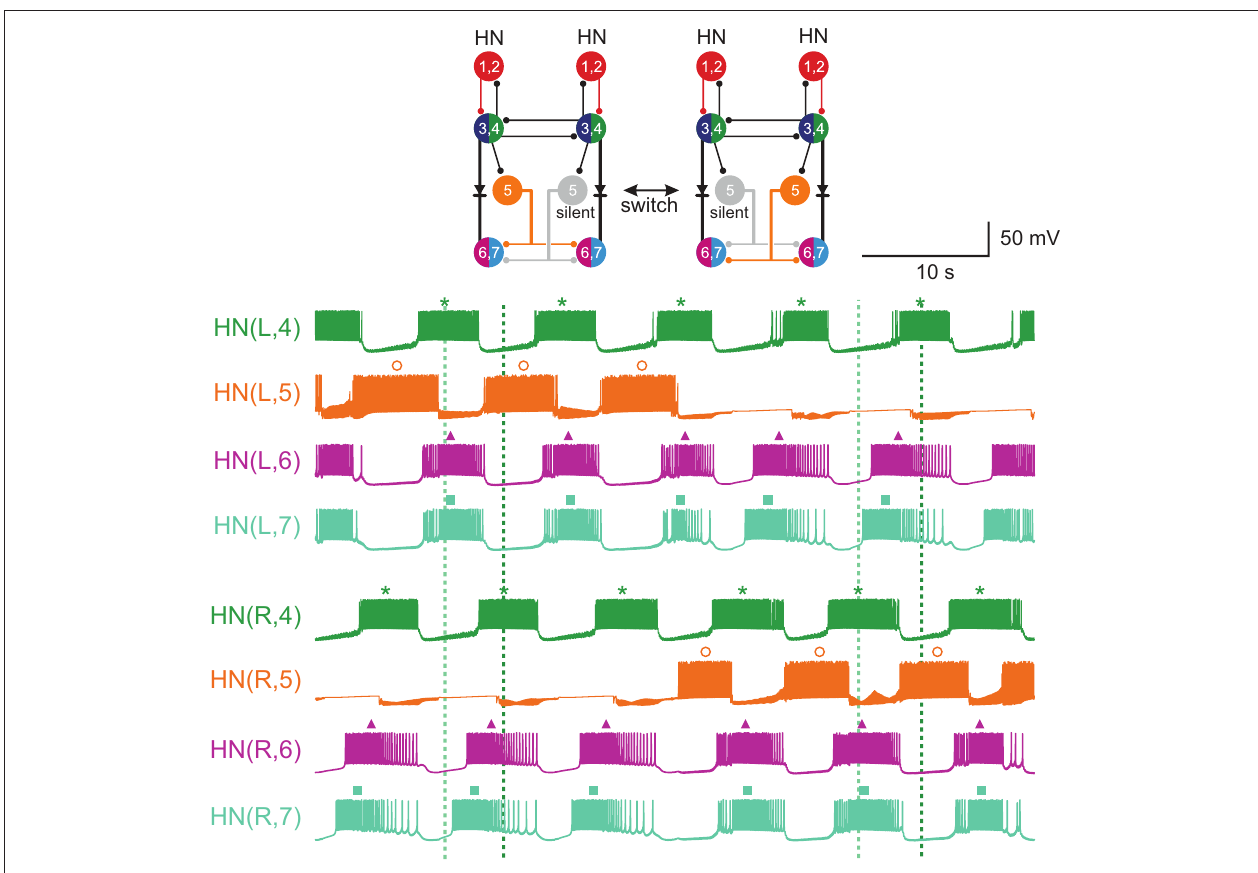
from one pair of front premotor interneurons, both pairs of middle premotor interneurons and the switch interneurons in the CPG model during this switch. Note the rapid readjustment of the phase of the middle premotor interneurons after the switch. The dark/light green dashed line indicates the firing phase of the peristaltic/synchronous HN(4)